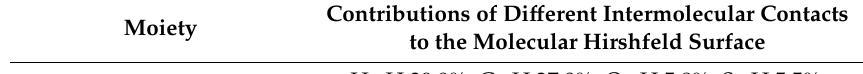
Figure 4. Hirshfeld surfaces for the [PhI(4-C 6 H 4 OMe)] + (left) and SCN – (right) ions.